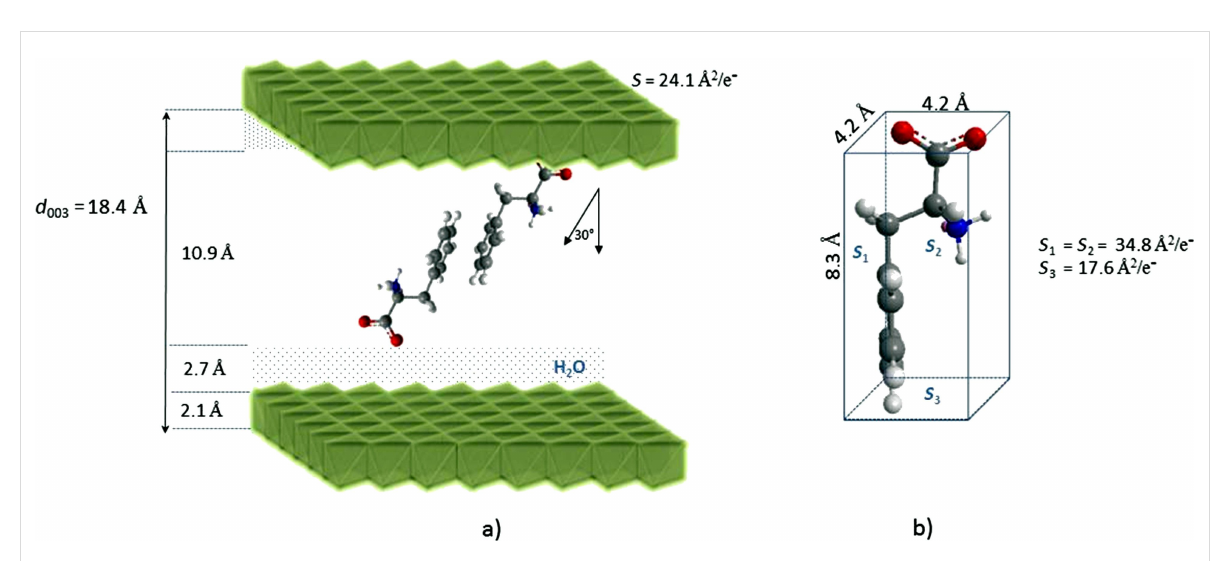
Figure 3: a) Structural model for Mg 2 Al/PHE, b) molecular structure of L-phenylalanine, dimensions and surface area per unit charge calculated by considering a rectangular parallelepiped